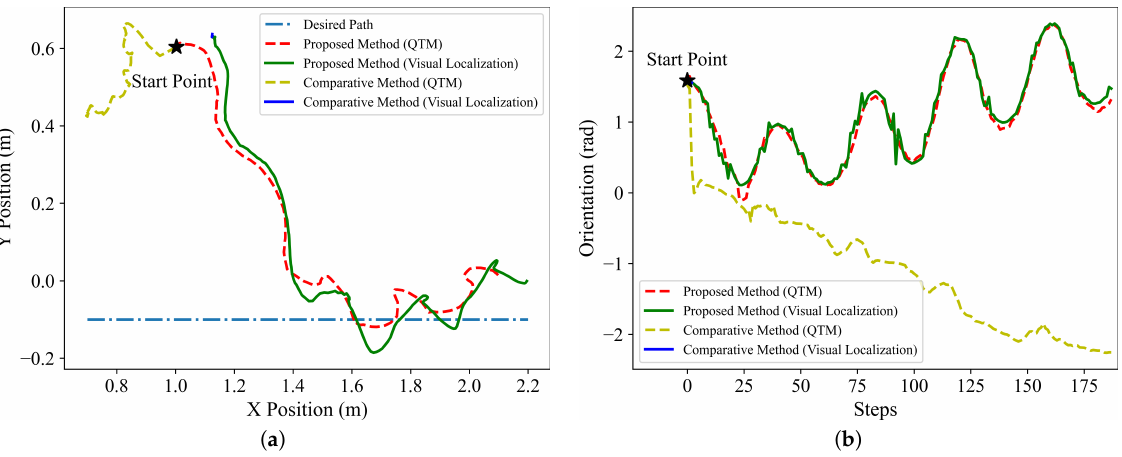
Figure 6. Results of visual localization for the trained policies with and without the visual stabilization item p h . ( a ) Position results. ( b ) Orientation results.